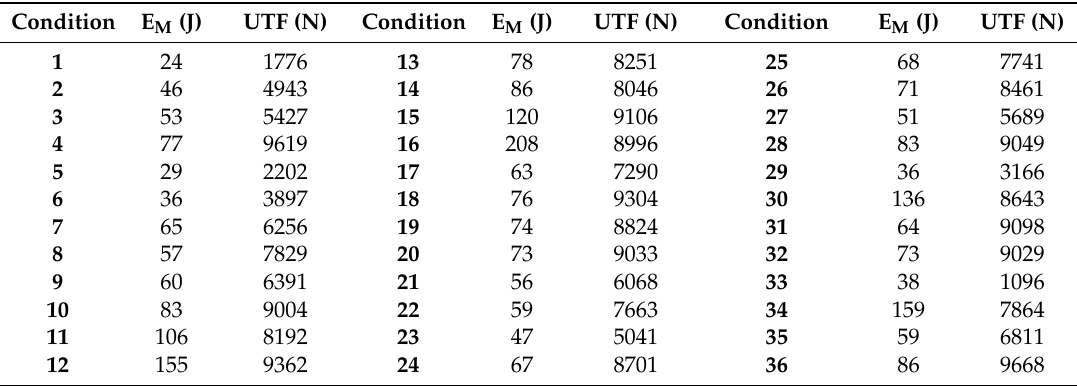
Table 5. Mechanical testing ultimate tensile force (UTF) Table 5 . Mechanical testing ultimate tensile force (UTF) results.